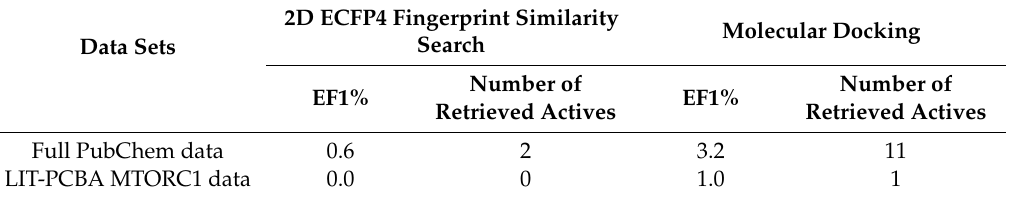
Table 2. Retrospective screening performance of a 2D ECFP4 fingerprint similarity search with Pipeline Pilot and molecular docking with Surflex-Dock on the full PubChem BioAssay data and the pruned LIT-PCBA MTORC1 ligand set, demonstrated by the enrichment in true actives at a constant 1% false positive rate over random picking (EF1%) values and the numbers of true actives retrieved along with the top 1% false positives by the “max-pooling”